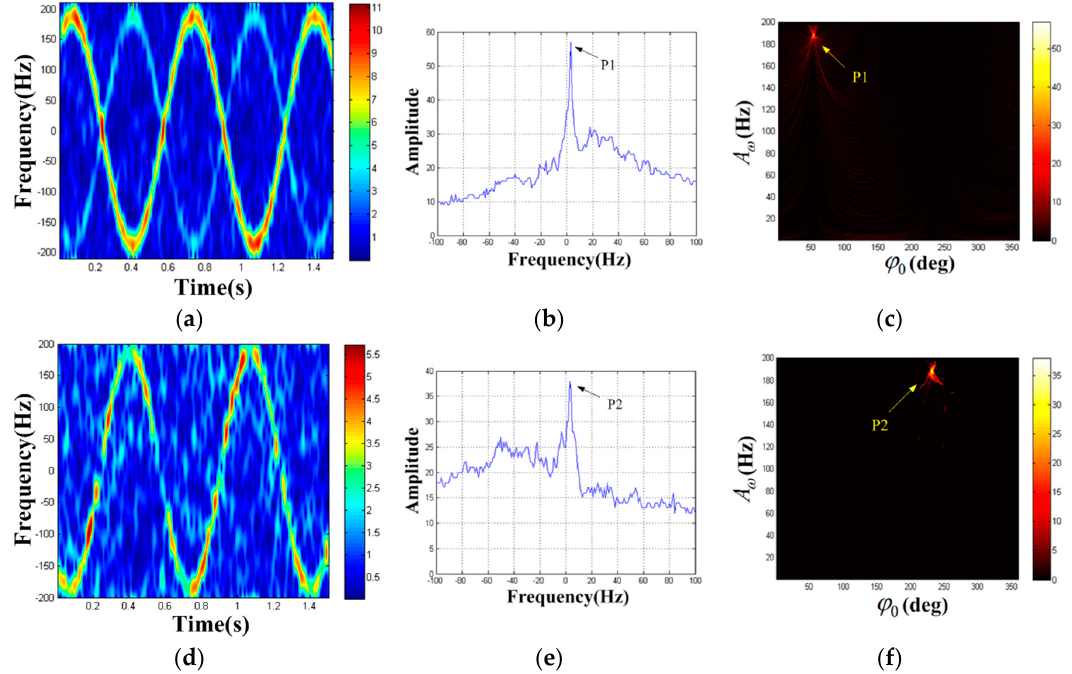
Figure 14. Simulation detection result of rotating angle reflectors. ( a ) TF distribution result of